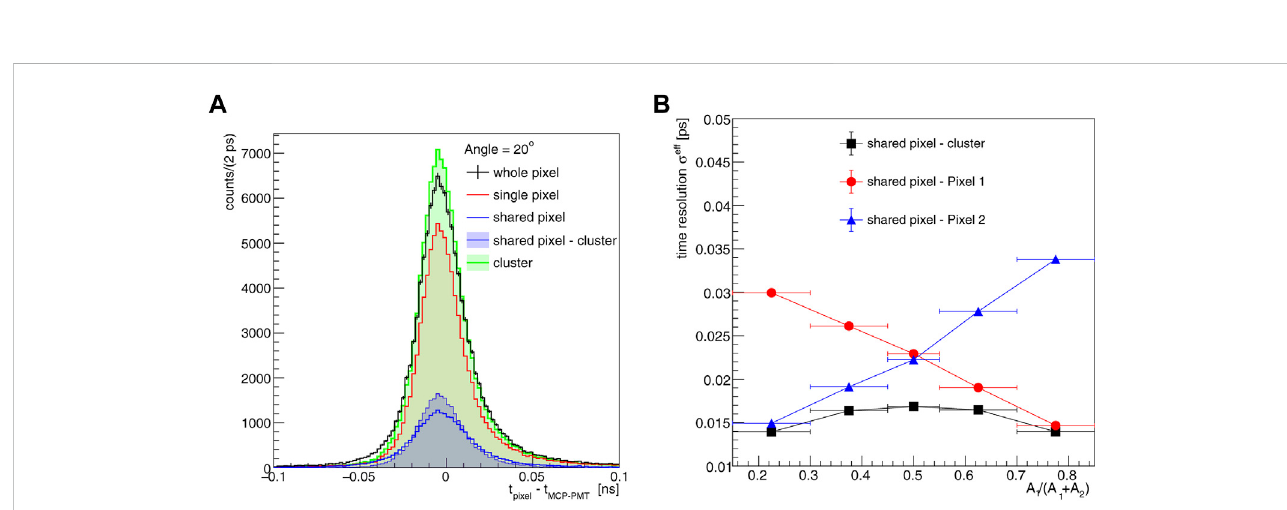
FIGURE 13 (A) Distributions of the TOA of the pixel with respect to the time reference for the different event categories; (B) Two-pixel cluster time resolution as a function of the ratio of the amplitude of one pixel to the sum of the two (black curve — See text for details). The time resolution estimated using only the individual pixel information is also shown (red and blue curves). The results correspond to an incident beam angle of 20 °